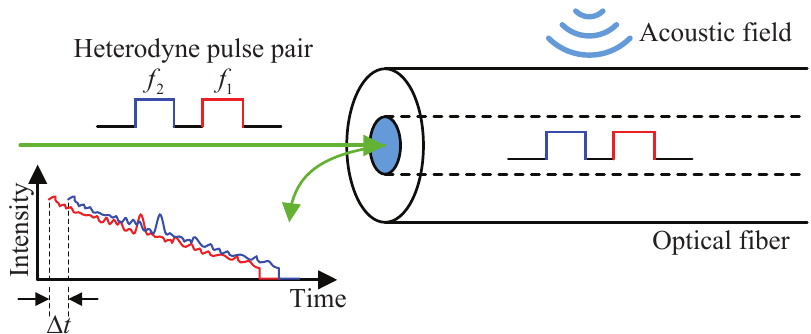
Figure 1. Working principle of the heterodyne demodulated distributed acoustic sensor (HD-DAS)